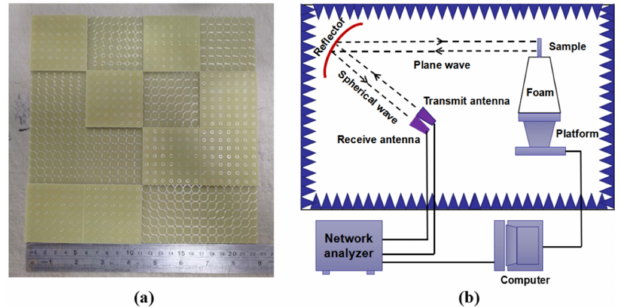
Figure 11. The fabricated metamaterial sample and test schematic: ( a ) the sample and ( b ) the schematic view of a compact range system for measurement.